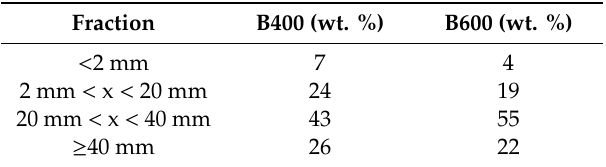
Table 3. Average particle size distribution after mechanical biochar processing with automatic remover